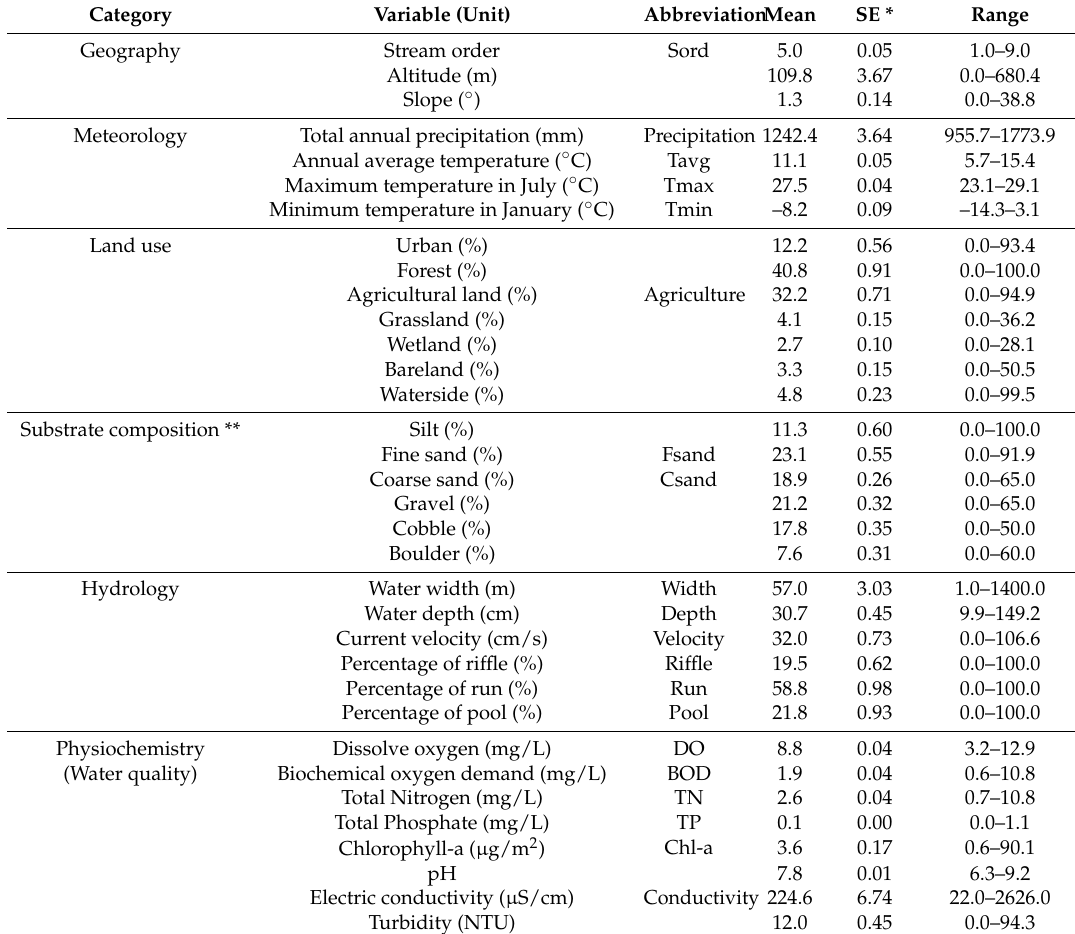
Table 1. Environmental characteristics of study